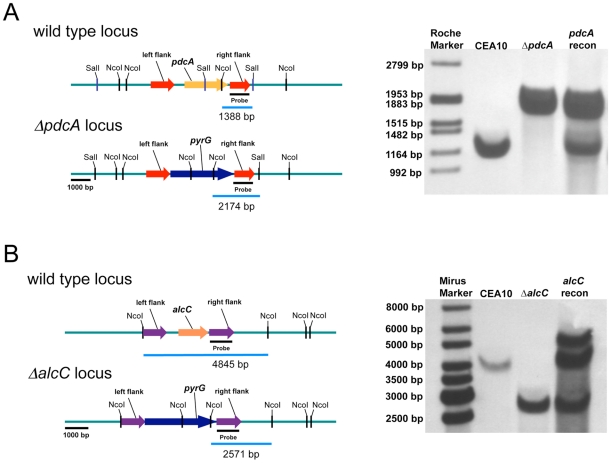
Generation and confirmation of PdcA and AlcC null mutants in A. fumigatus.Schematic of wild type (CEA10), PdcA (A), and AlcC (B) null mutant genomic loci. (A) Southern blot analysis of wild type, ΔpdcA, and pdcA recon strains as well as (B) wild type, ΔalcC, and alcC recon strains. Genomic DNA from the respective strains was isolated and digested overnight with SalI and NcoI in the case of PdcA and with only NcoI for AlcC. An approximate 1 kb genomic region was utilized as a probe. The expected hybridization patterns and sizes were observed for all strains tested. In addition, confirmation of ectopic reconstitution was confirmed by the presence of the wild type locus hybridization signal and persistence of the null mutant locus. The alcC reconstituted strain showed a double re-insertion of the alcC locus.